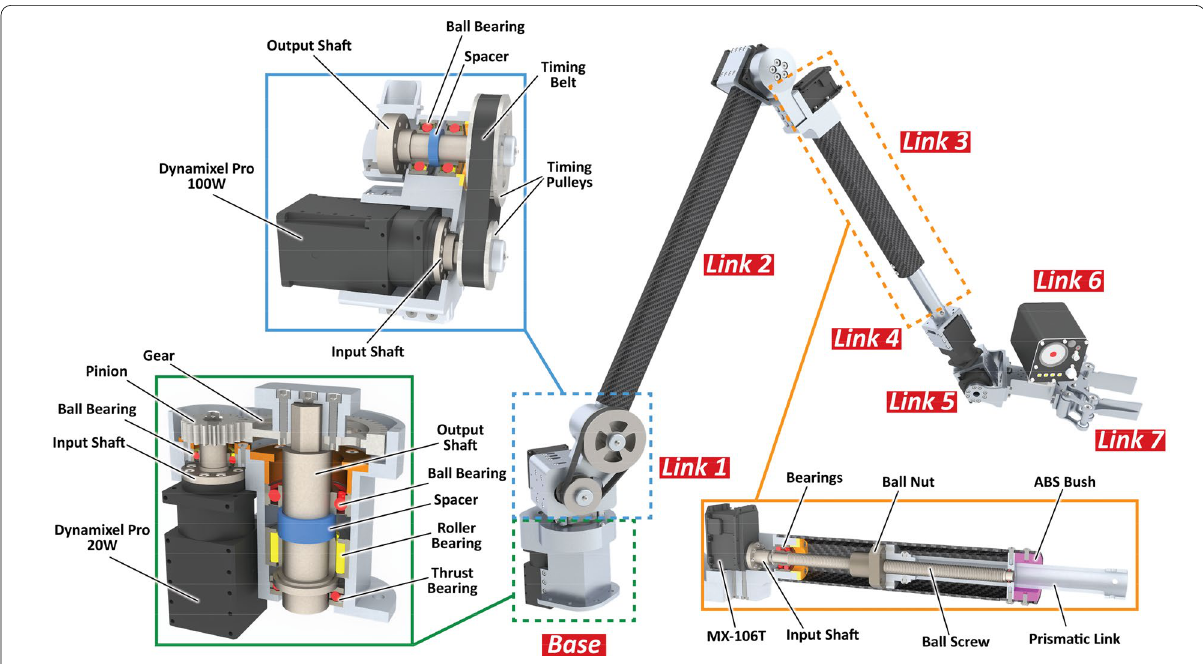
Fig. 9 Link arrangement and mechanism design of Karo’s manipulator in